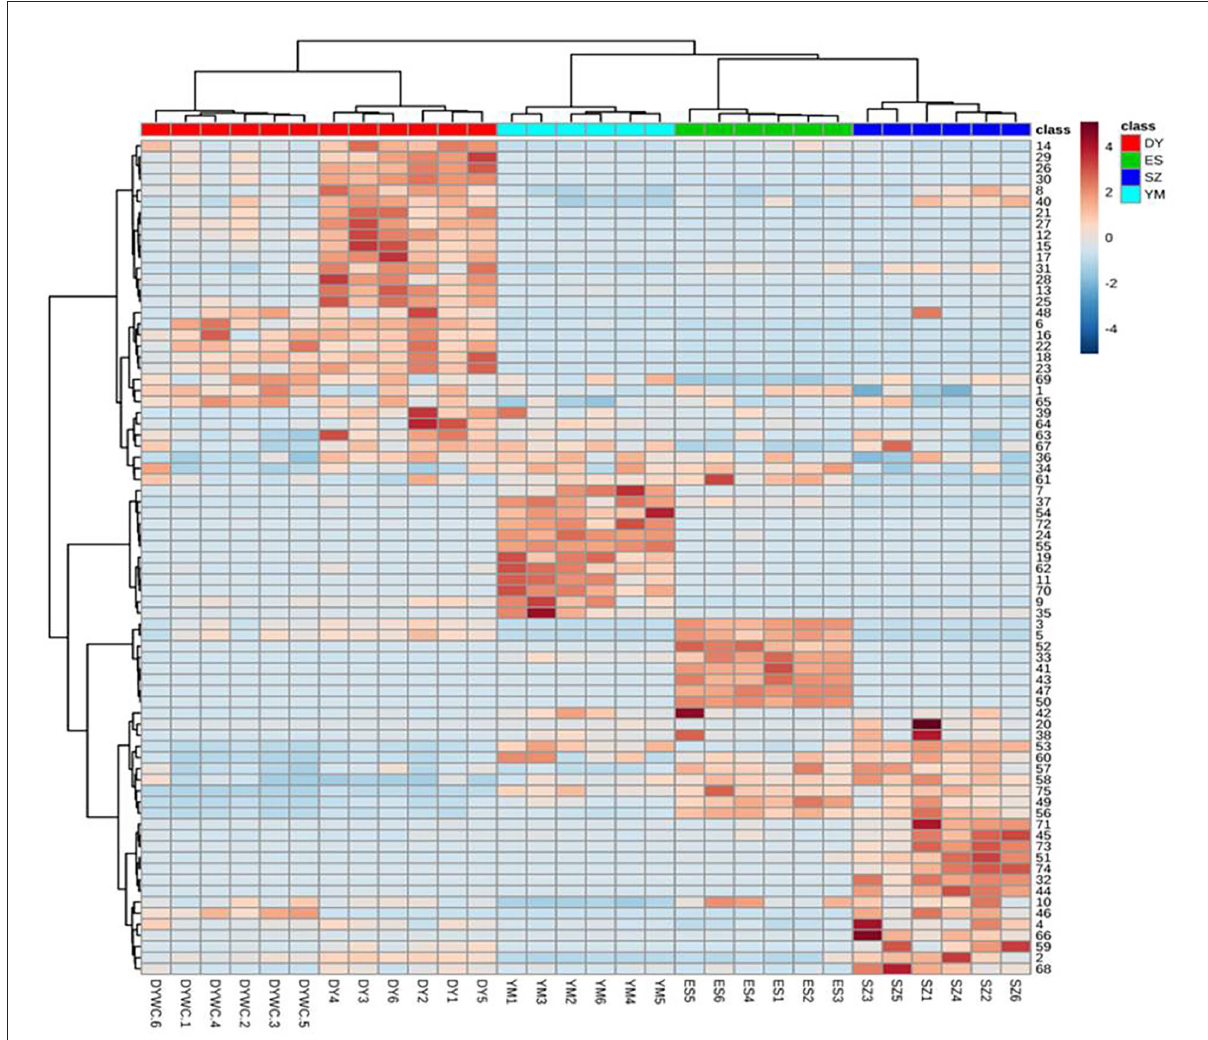
FIGURE4 The heat map of identified differential metabolites of Oxytropis. (Darker brown indicates higher contents. The figures on the right correspond to compound number order in Supplementary Table S1).